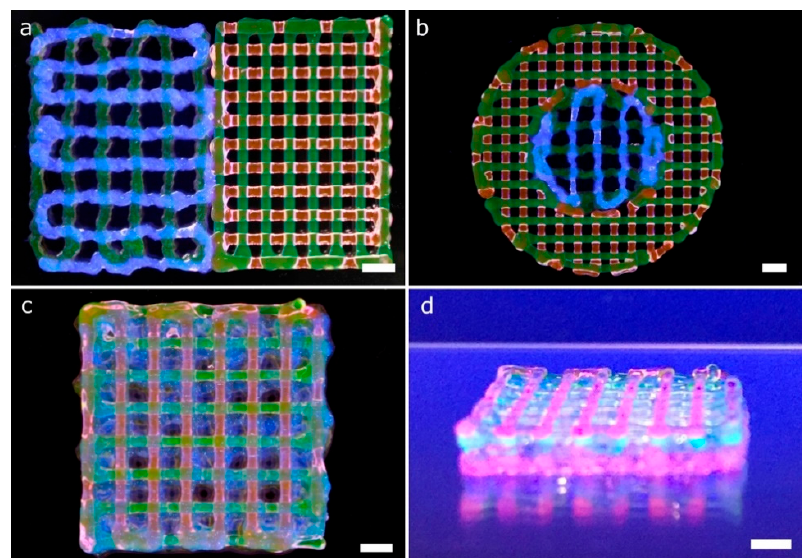
Figure 14. Complex multi-material structures printed. Gel-Alg and P407 bioinks were printed using 25G and 27G tapered nozzles, respectively. ( a ) general view of a 2-layer porous lattice structures printed with Gel-Alg (left, green for printhead 1 and blue for printhead 2) and P407 (right, green for printhead 3 and red for printhead 4) bioinks; ( b ) general view of circular lattice structure with the inner circle printed in Gel-Alg (green for printhead 1 and blue for printhead 2), and the outer circle printed in P407 (green for printhead 3 and red for printhead 4); general ( c ) and side view ( d ) of an 8-layer porous lattice with alternating layers of Gel-Alg and P407. Sequence of colors: Gel-Alg (orange), Gel-Alg (blue), P407 (green) and P407 (red); scale bars: 2 mm.